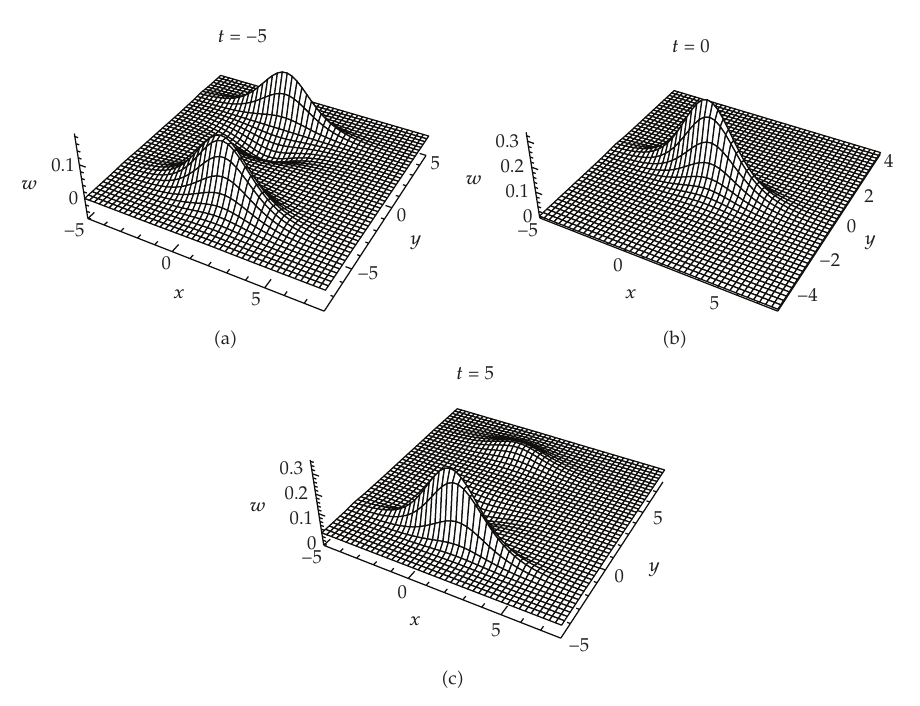
Figure 1: The evolution of three dromions-like for (cid:2) 4.2 (cid:4)